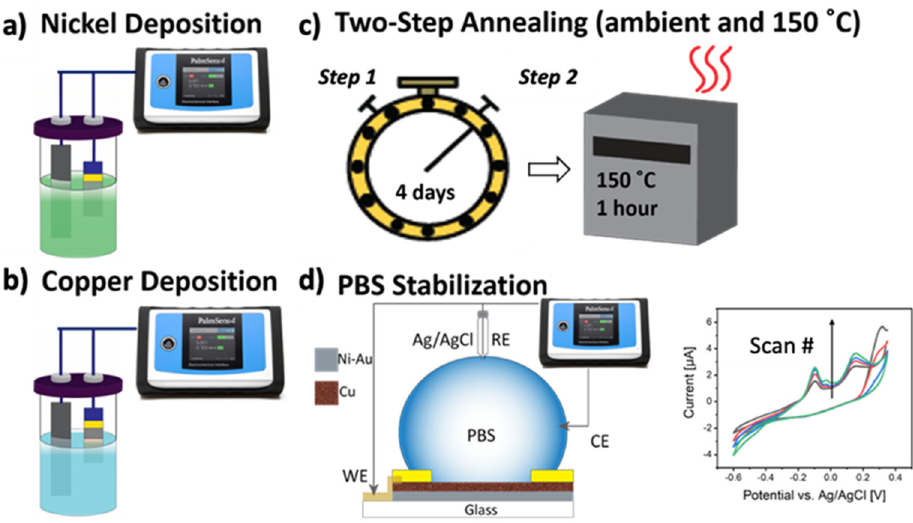
Figure 1. Schematic for fabrication of phosphate-buffered saline (PBS)-Cu-Ni working electrodes. ( a ) Electrodeposition of nickel (Ni) followed by ( b ) copper (Cu) electrodeposition at 50 °C for 2 min. ( c ) The two-step annealing process, with Step 1 in air at room-temperature for four days, followed by Step 2 at 150 °C for 1 h. ( d ) Electrochemical treatment of Cu-Ni electrodes in PBS (pH = 7.4) using cyclic voltammetry (CV) with a scan rate of 50 mV s − 1 . At least 45 scans are performed until CV curves are stabilized. The inset shows representative CV curves.